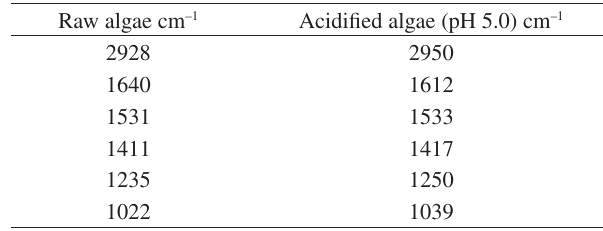
Table 3. Changes promoted by treatment acid at pH 5.0